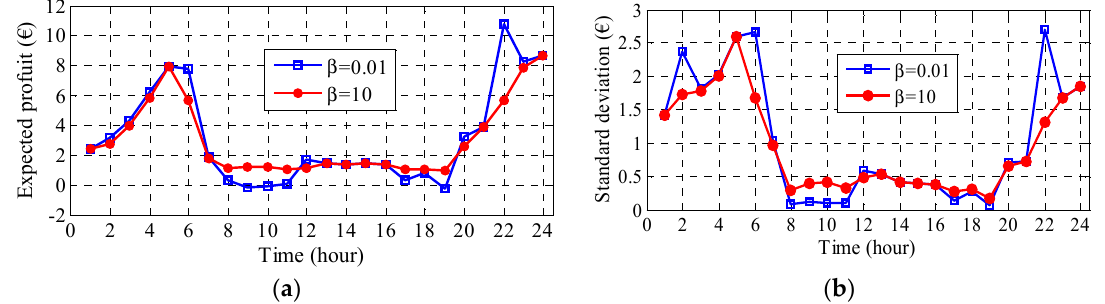
Figure 8. ( a ) The expected profit; ( b ) standard deviation of profits during scheduling horizon.